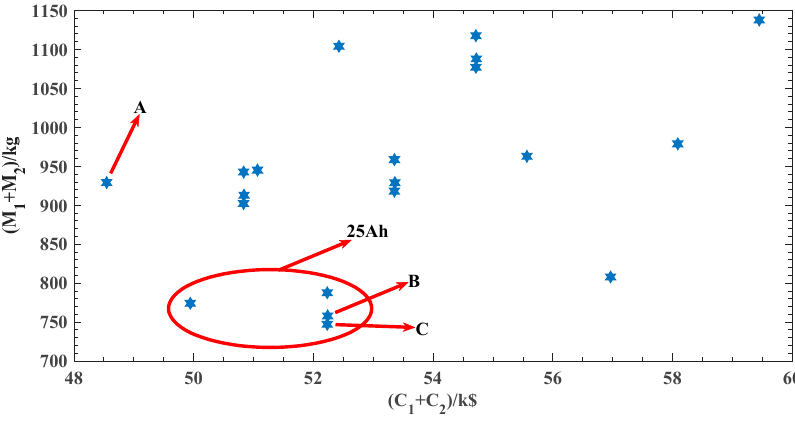
Figure 3. The HESS parameter optimization results.